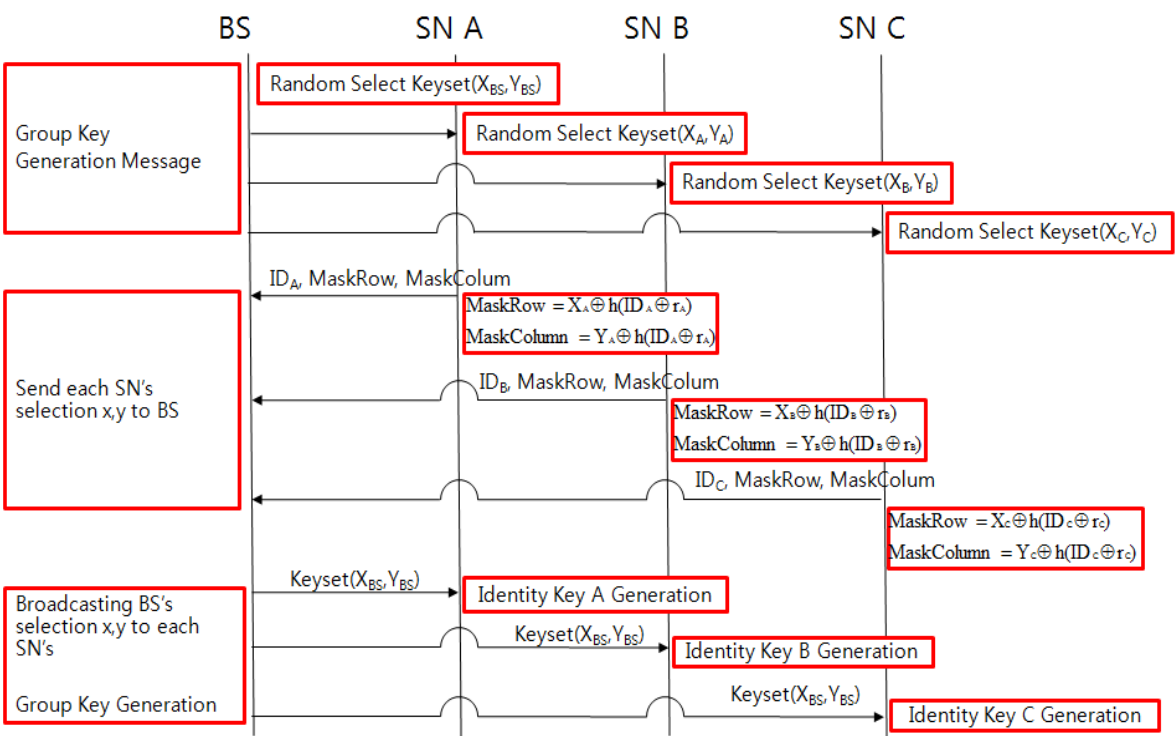
Figure 6. Group Key Creation and Identity Key Exchange